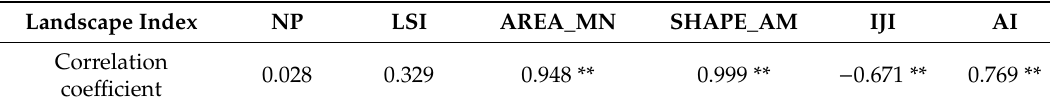
Table 4. Correlations of landscape patterns and